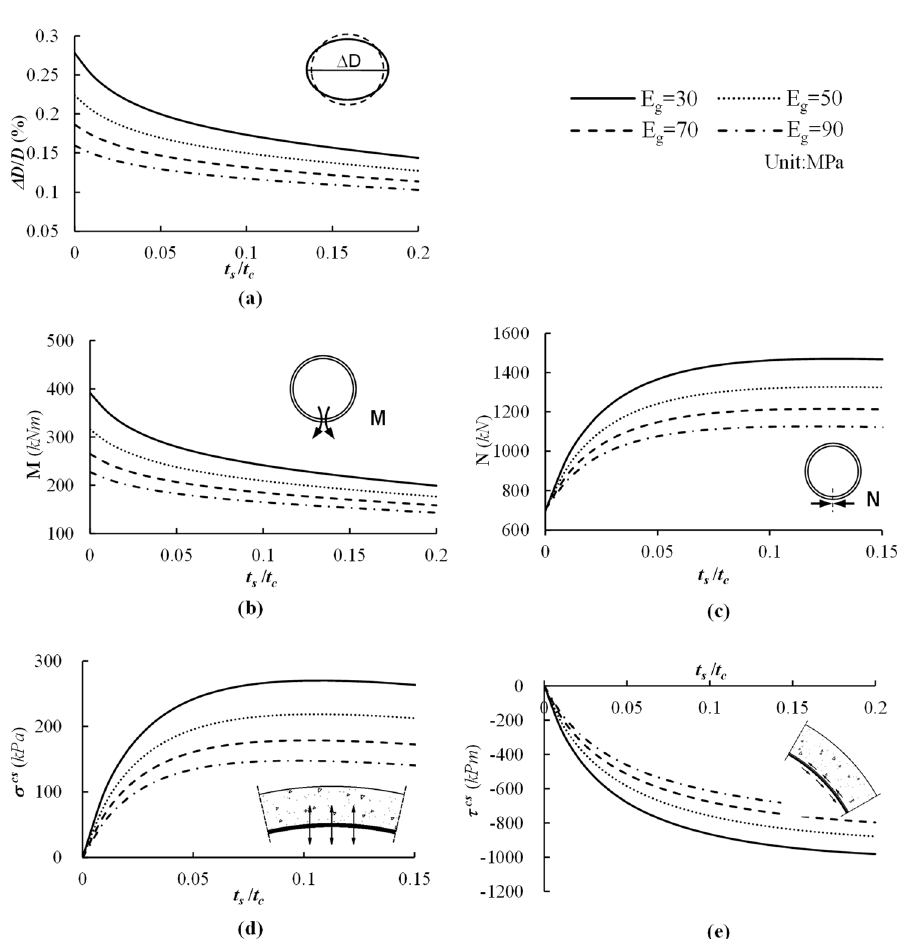
Figure 18. Influence of the steel plate thickness on performance of the strengthened tunnel, ( a ) de- formation, ( b ) moment at tunnel invert, ( c ) axial force at tunnel invert, ( d ) interface tension stress at tunnel crown, ( e ) peak interface shear stress.